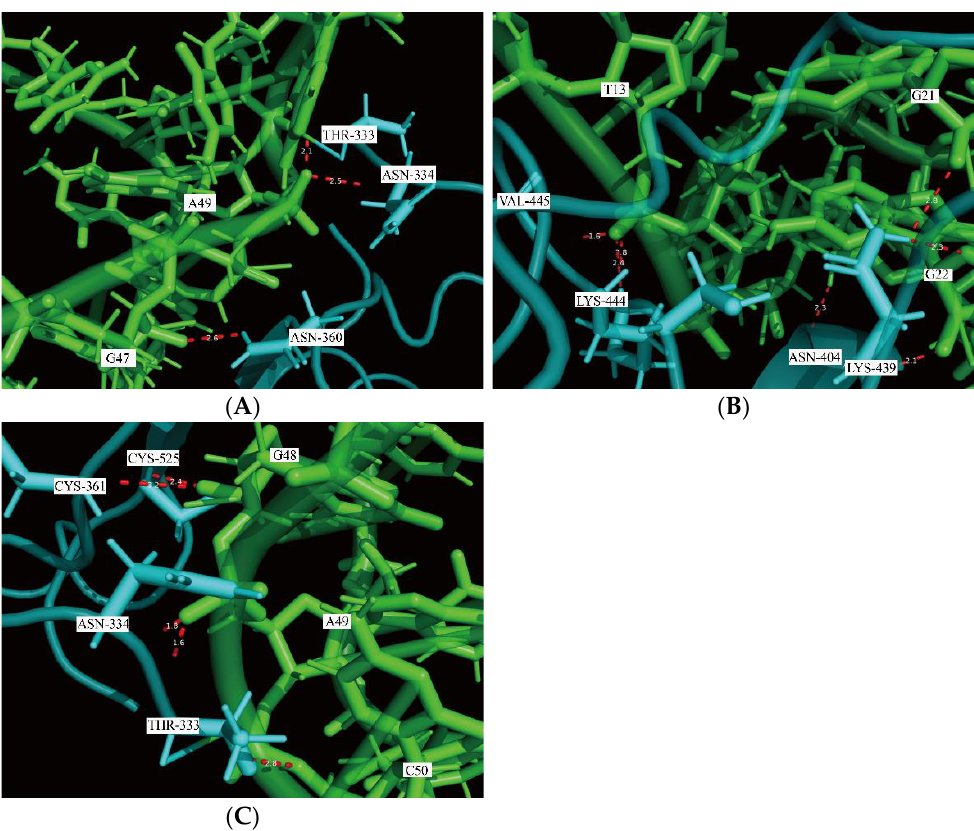
Figure 6. Visualization of the hydrogen bonds formed by the DNA aptamer and S protein in the last frame of MD simulation using PyMOL 2.5. The aptamer is colored in light green, the S protein in light blue, and hydrogen bonds shown by red dashed lines. ( A ) Three H-bonds formed in the binding interface of the S protein/RBD-1C complex, ( B ) seven H-bonds in the binding interface of the S protein/RBD-1CM1 complex, and ( C ) five H-bonds in the binding interface of the S protein/RBD-1CM2 complex.